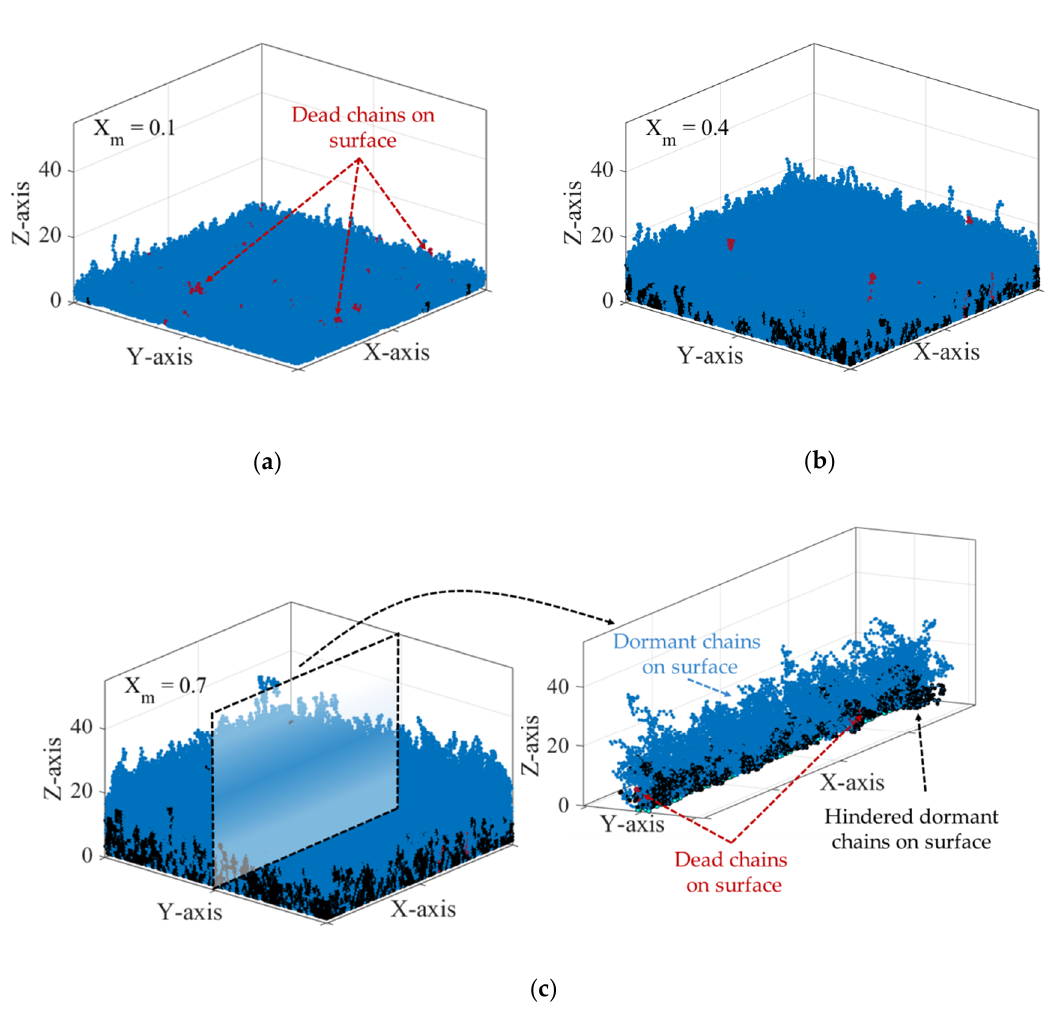
Figure 7. Snapshot of the polymer layer grown; same references conditions as in Figures 4–6 thus with specifically the translational mode to describe the termination between a solution and surface active species. The snapshots are taken at three di ff erent monomer conversions: ( a ) X m = 0.1; ( b ) X m = 0.4; ( c ) X m = 0.7. Surface-tethered dormant chains are represented in blue, dead chains on the surface are represented in red, while the hindered dormant chains that cannot continue to propagate by means of the RDPR activation-growth-deactivation mechanismdue to shielding are represented in black. A zoom of the middle section ( Y -axis) of the polymer layer in ( c ) at X m = 0.7 to facilitate the di ff erentiation of these three groups of polymer